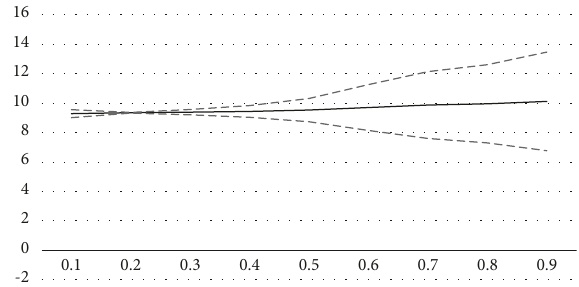
Figure 2: Quantity-EPU quantile regression result.